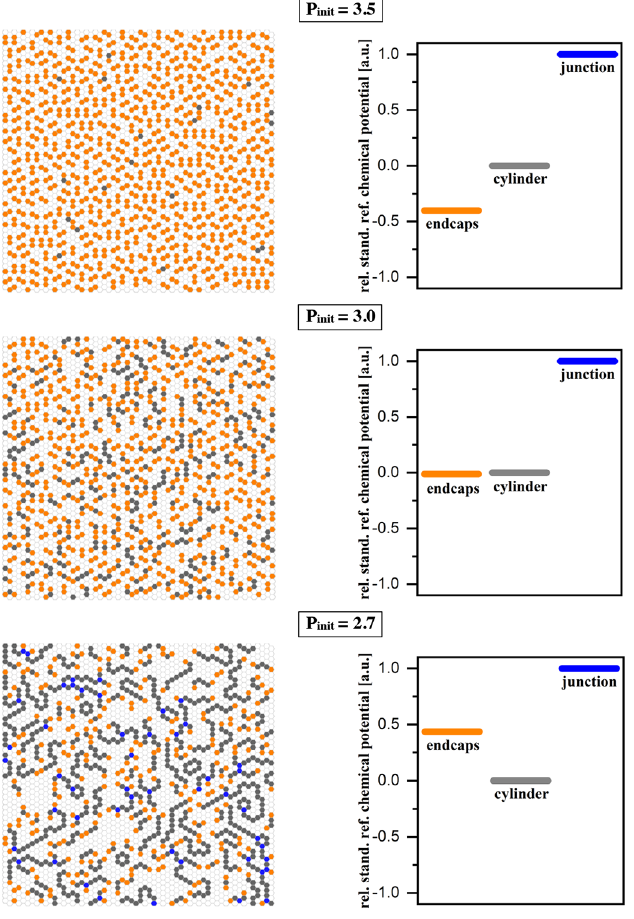
Fig. 15. Two-dimensional image of the organic phase and rel. standard reference chemical potential at x =0.35 with different initial spontaneous packing parameters P init . The structural composition and the corresponding microphase distribution are shown in Figure 14.